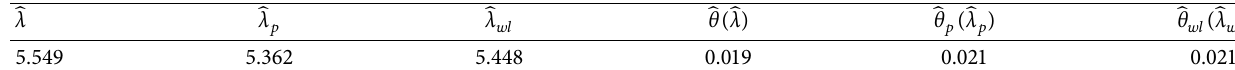
Table 3: Estimates of λ and θ for real data.